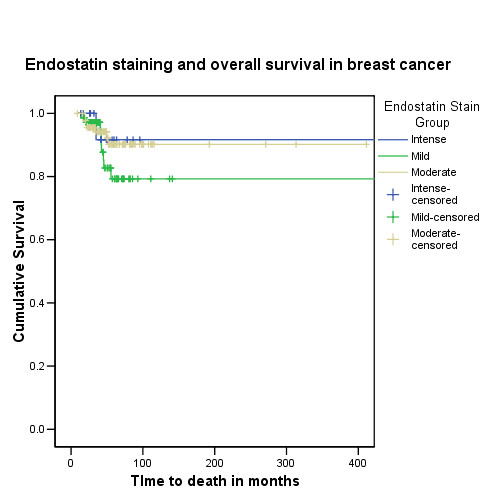
Intensity of Endostatin staining on the breast cancer tissue micro array and overall survival in invasive breast cancer. There were 9 events in 71 patients with mild staining, 7 events in 91 patients with moderate staining and 1 event in 17 patients with intense staining. (Total number = 179; log rank test statistic-1.83; df = 2; p = 0.40)